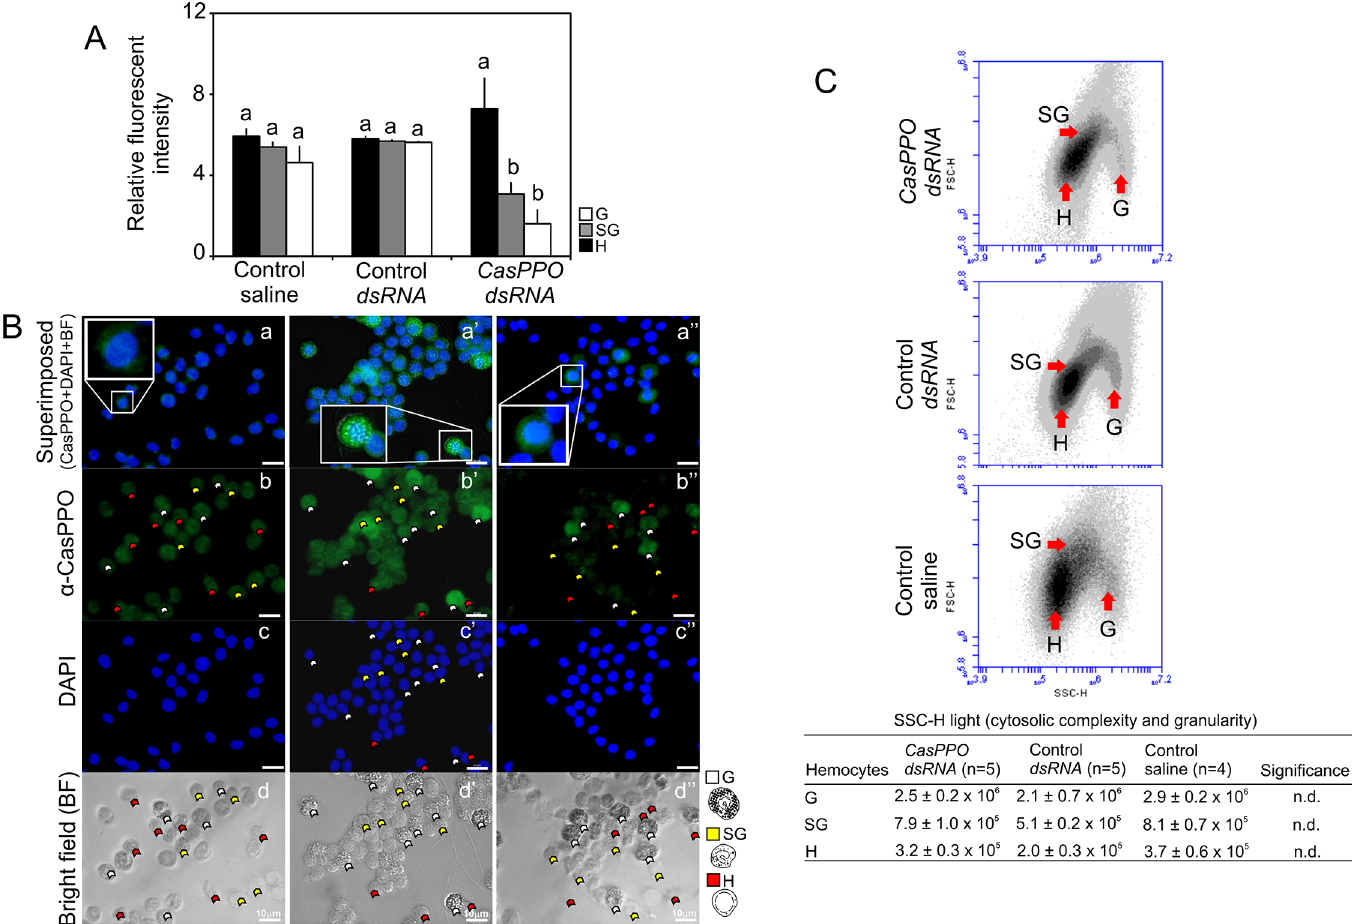
Fig 3. Levels of CasPPO-hemo in hemocytes after multiple injections of CasPPO-hemo-dsRNA . (A) Fluorescent intensity analysis, (B) ICC (left to right = control saline, control dsRNA , CasPPO-hemo dsRNA ), and (C) flow cytometry analysis of hemocytes from CasPPO-hemo-dsRNA and control groups. The positive α -CasPPO-hemo immnunopositve staining of the cells obtained at 24 hrs after ecydsis was determined for fluorescent intensity, which was calculated using ImageJ. The insertion in the ICC pictures shows a positive hyaline cell (a) and granulocyte (a ’ and a ” ). The flow cytometry indicates no changes in the cytosolic complexity and granularity of hemocytes in the CasPPO-hemo - dsRNA injected group. The values of cytosolic complexity (SSC-H) are shown as mean ± SE (n = 4 – 5). Different letters indicate significant differences at P < 0.05: B and C) Two way ANOVA. n.d. = no significant differences. Bar sacle = 10 μ m. G = granulocytes; SG = semigranulocytes; H = hyaline